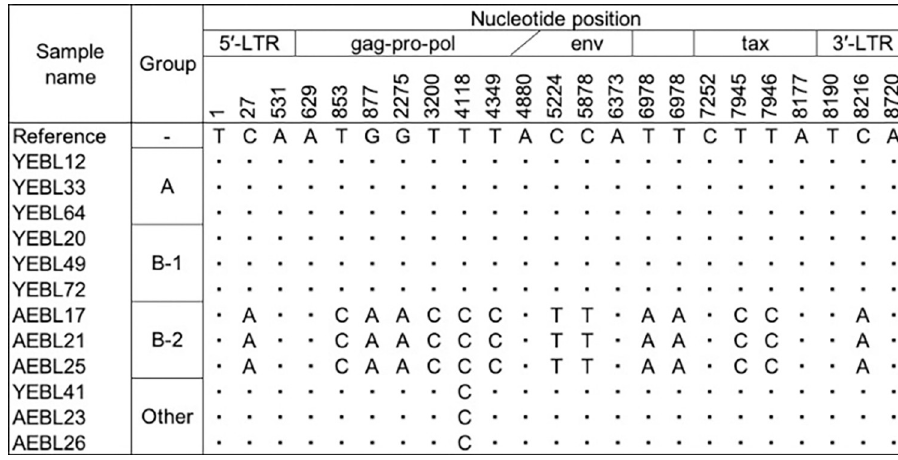
Fig 3. Summary of representative nucleotide substitutions among groups A, B-1, B-2 and Other. The dots (” � “) indicate the same nucleotide. 1: cytosine and B-2: adenine) (Fig 3). These nucleotide substitutions were located in 5 0 and 3 0 long terminal repeat (LTR), gag-pro-pol , env and tax regions. The substitutions of nucleotide